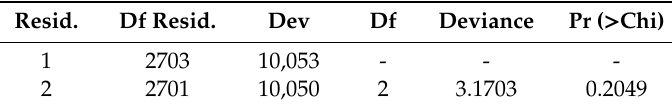
Table 29. Comparison of model II and III by ANOVA.